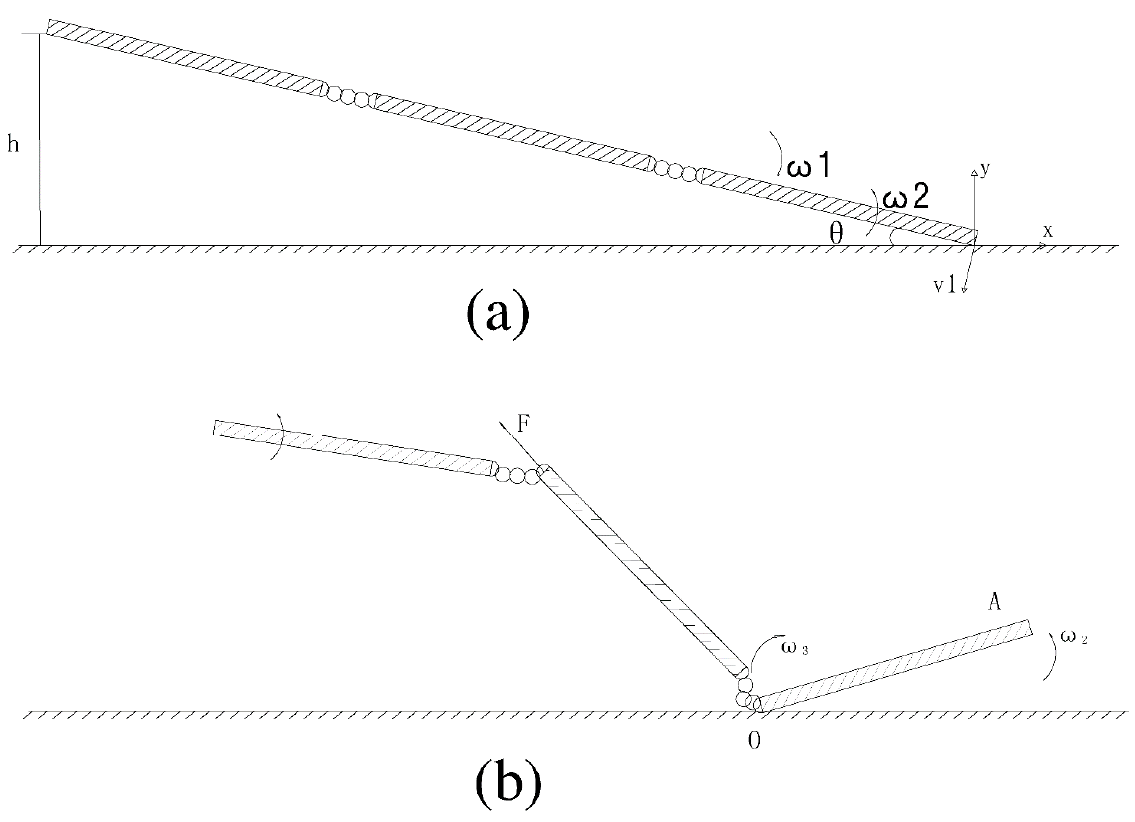
Figure 4. Diagram of the moment of three-section cudgel wrestling ( a ) and retrieving ( b ).